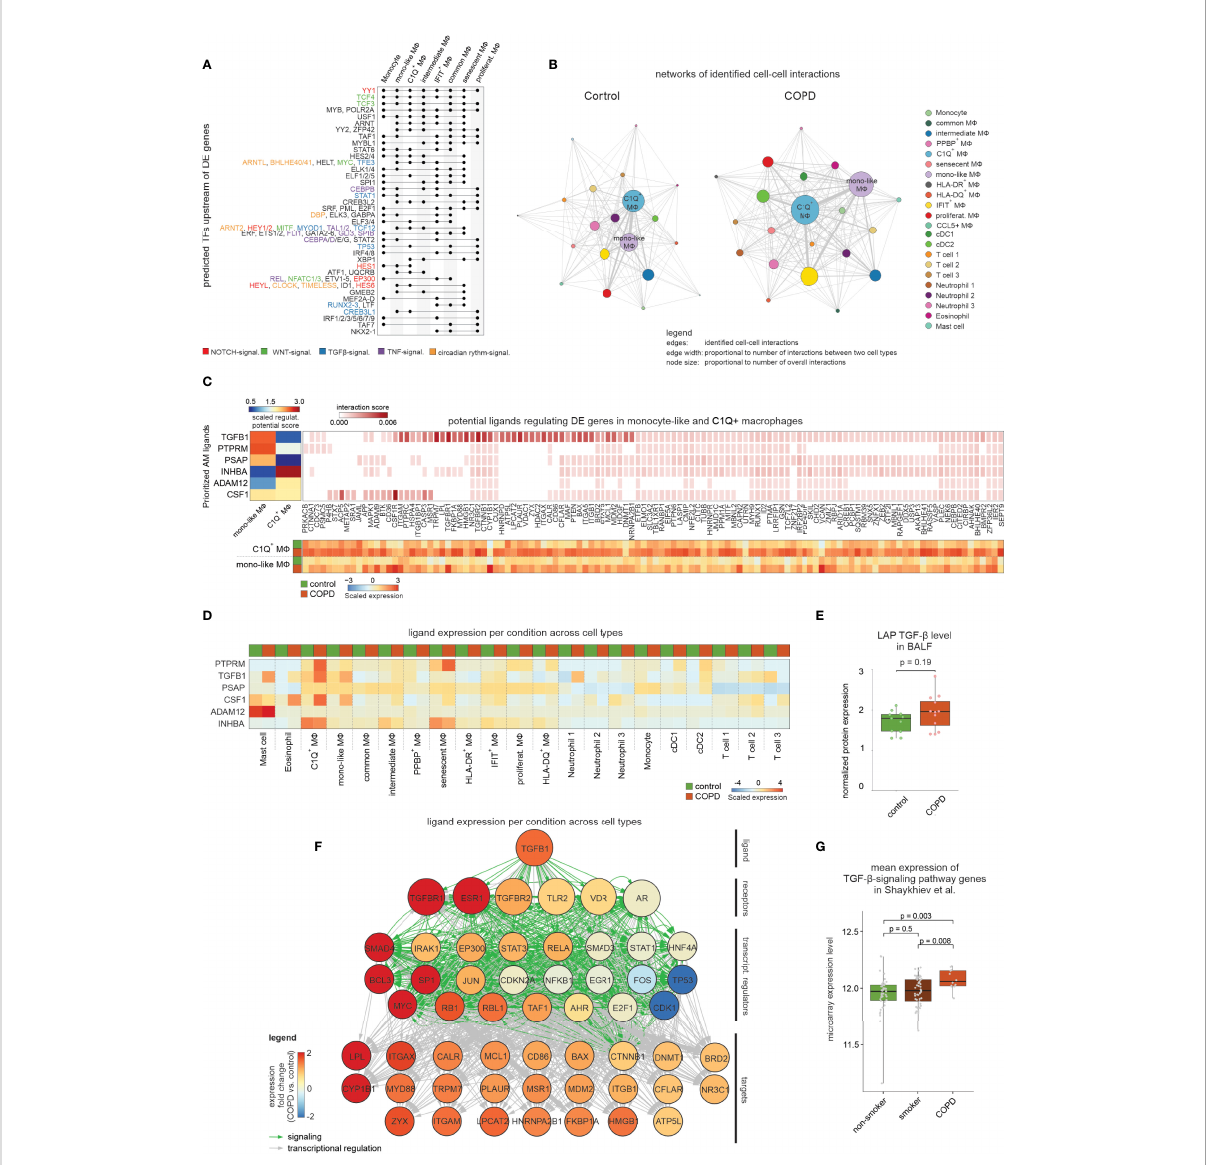
FIGURE 5 Modeling the cell-to-cell interactions of BALF cells. (A) UpSet plot of predicted transcriptional regulators of DE genes. Dots indicate which clusters contain and share predicted transcriptional regulators. The names of selected regulators are shown on the right side of the plot with the font color indicating the association with NOTCH, WNT, TGF- b 1, TNF or circadian rhythm signaling. (B) Network representation of predicted cell-to-cell interactions derived from CellPhoneDB. The names of the two most interconnected cell types are displayed (edge: identi fi ed cell- to-cell interaction; edge width: proportional to number of interactions between two cell types; node size: proportional to number of overall interactions). (C) Results of NicheNet analysis, in which the heatmap in the top left corner displays the z-normalized ligand activity scores (based on area under the precision recall curve (AUPR)) of the top 3 ligands for either the DE genes from C1Q+ macrophages or monocyte-like macrophages, respectively. On the right the top 250 interaction scores of the ligands ’ target genes are colored by their interaction score. The heatmap at the bottom represents the mean expression (z-transformed by gene across all macrophage states; according to Figure S5D) of the ligands ’ target genes in C1Q+ macrophages or monocyte-like macrophages from control and COPD. (D) The mean expression of the top 6 ligands in all identi fi ed BALF cell types for either COPD or control patients (z-transformed by gene) is displayed. (E) Box plot with marked median of the measured protein expression (by Olink Proteomics) in BALF of LAP TGF- b 1 in COPD and control with representation of individual donors (control n = 11, COPD n = 12; error bars indicating the standard deviation; statistics based on Wilcoxon rank sum test). (F) Representation of inferred ligand-to-target signaling path for TGF- b 1 derived from the NicheNet analysis. The nodes representing the genes are colored by the expression fold change between COPD and control patients. (G) Box plots (with marked median values) showing the mean expression per sample of TGF- b -signaling genes (error bars indicating the standard deviation; statistics are based on the Wilcoxon rank sum test). The underlying data are obtained from Shaykhiev et al. (17). signal., signaling; TF, transcription factor; M Ф , macrophage; regulat., regulatory; mono, monocyte; DC, dendritic cell; transcript.,